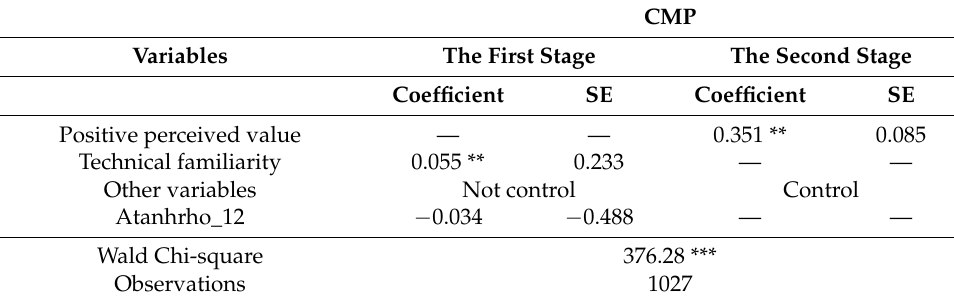
Table 3. The effect of positive perceived value on FWA.